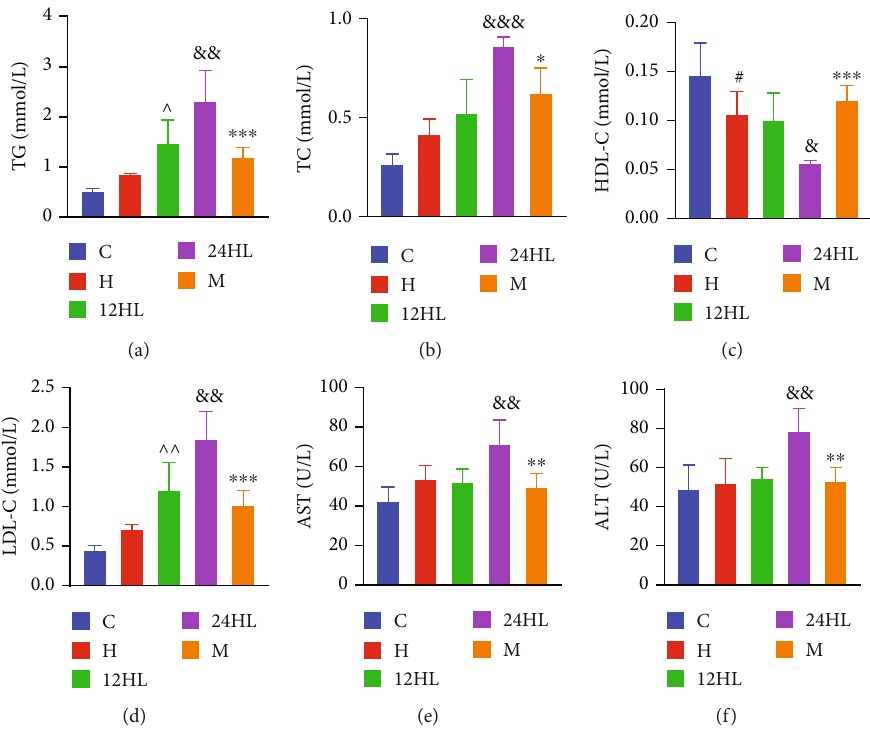
Figure 3: E ff ect of melatonin on blood lipid metabolism. (a) TG, (b) TC, (c) HDL-C, (d) LDL-C, (e) AST, and (f) ALT after treatment (on week 10). C: control group; H: HFD group; 12HL: 12 h light group; 24HL: 24 h light group; M: melatonin group. The values are expressed as the means ± S : D : ( n = 6 -8 per group). # P < 0 : 05 , HFD vs. control; ^ P < 0 : 05 , and ^^ P < 0 : 01 , 12HL vs. HFD group; & P < 0 : 05 , && P < 0 : 01 , and &&& P < 0 : 001 , 24HL vs. 12HL group; ∗ P < 0 : 05 , ∗∗ P < 0 : 01 , and ∗∗∗ P < 0 : 001 , M vs. 24HL